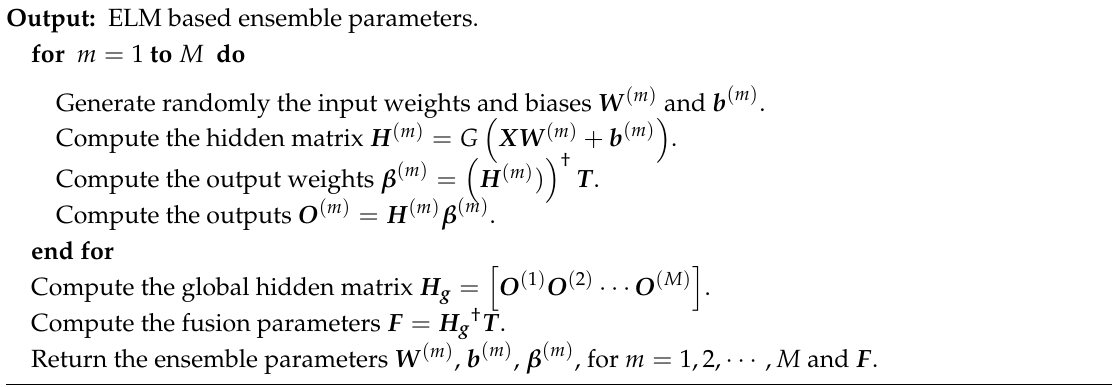
Algorithm 2 Training of the ELM based ensemble for